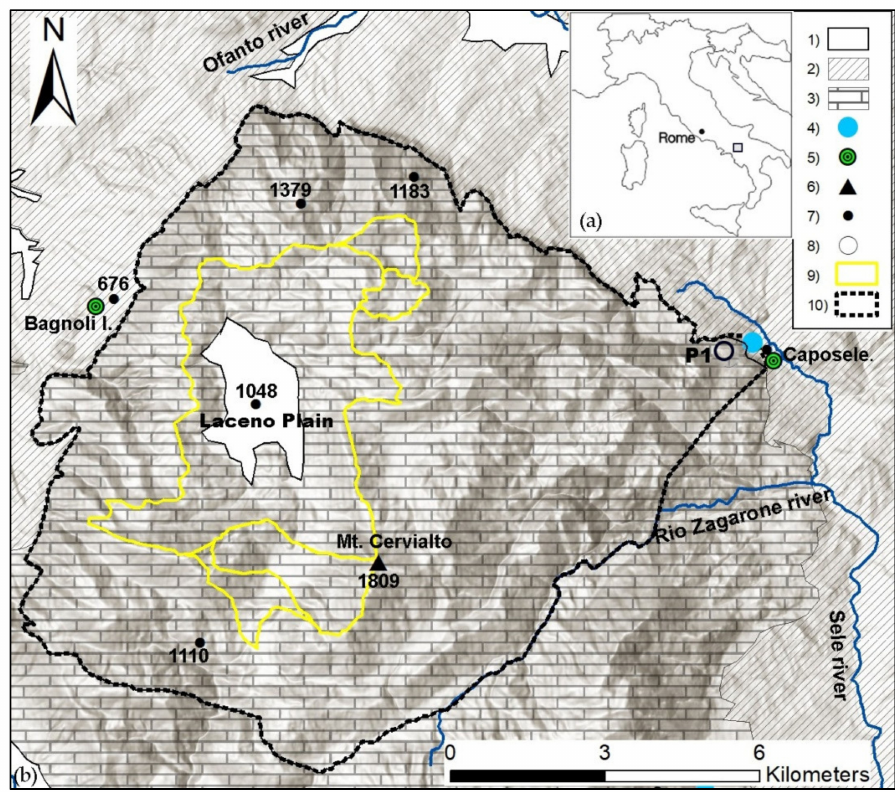
Figure 4. (a) Italy and study area; (b) relief map with hydrogeological features of the Caposele spring catchment. (1) Slope breccias and debris, pyroclastic, alluvial and lacustrine deposits (Quaternary); (2) argillaceous complex and flysch sequences (Paleogene–Miocene); (3) calcareous-dolomite series (Jurassic–Miocene); (4) Caposele spring; (5) village; (6) mountain peak; (7) elevation (m. a.s.l.); (8) borehole; (9) endorheic areas; and (10) spring